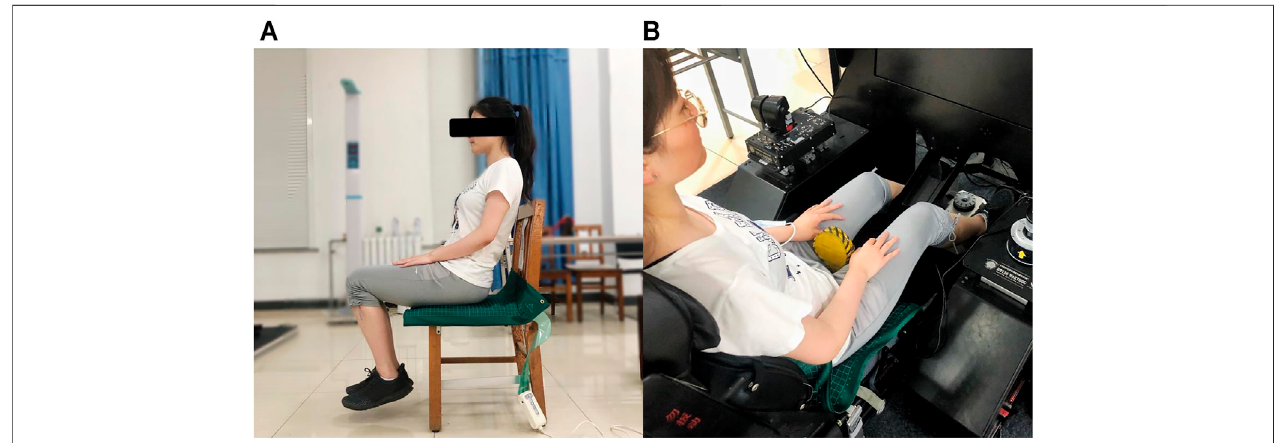
FIGURE 3 | (A) The sitting posture of participants to calibrate. (B) The sitting posture of participants to collect the pressure.